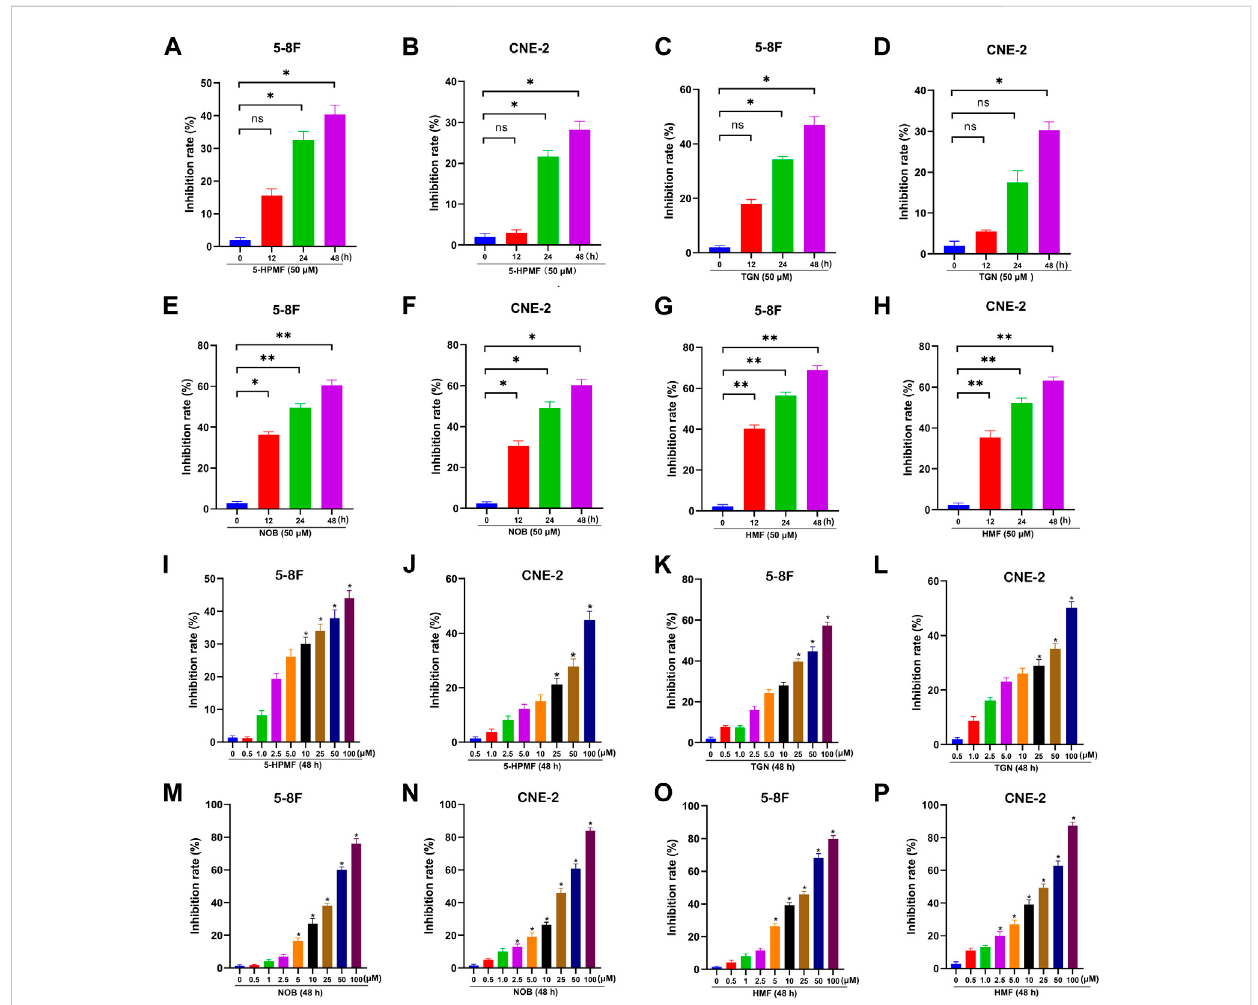
FIGURE 2 Anti-proliferation effects of the four PMFs (5-HPMF, TGN, NOB, and HMF) in human nasopharyngeal carcinoma cells. (A – H) 5-8F and CNE-2 cell lines were incubated with the four PMFs (50 μ M) for 12 h, 24 h, and 48 h, respectively. (I – P) 5-8F and CNE-2 cell lines were incubated with different concentrations (0, 0.5, 1, 2.5, 5, 10, 25, 50, and 100 μ M) of the four PMFs for 48 h. Cell viability was examined by CCK-8 assay. All data were described as the mean ± SD of three independent and repeated experiments. Compared to the control group (0 μ M): * p < 0.05; ** p < 0.01; ns, not signi fi